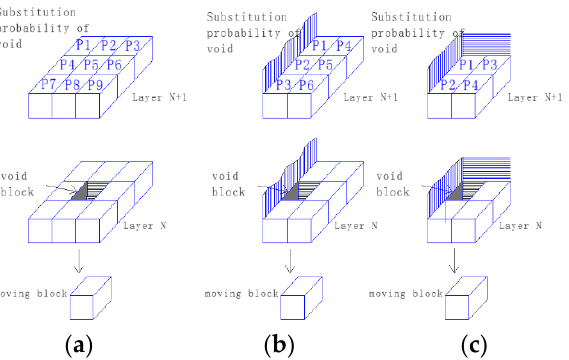
Figure 2. Transfer model of void blocks. ( a ) Nine-block model; ( b ) Six-block model; ( c ) Four-block model.